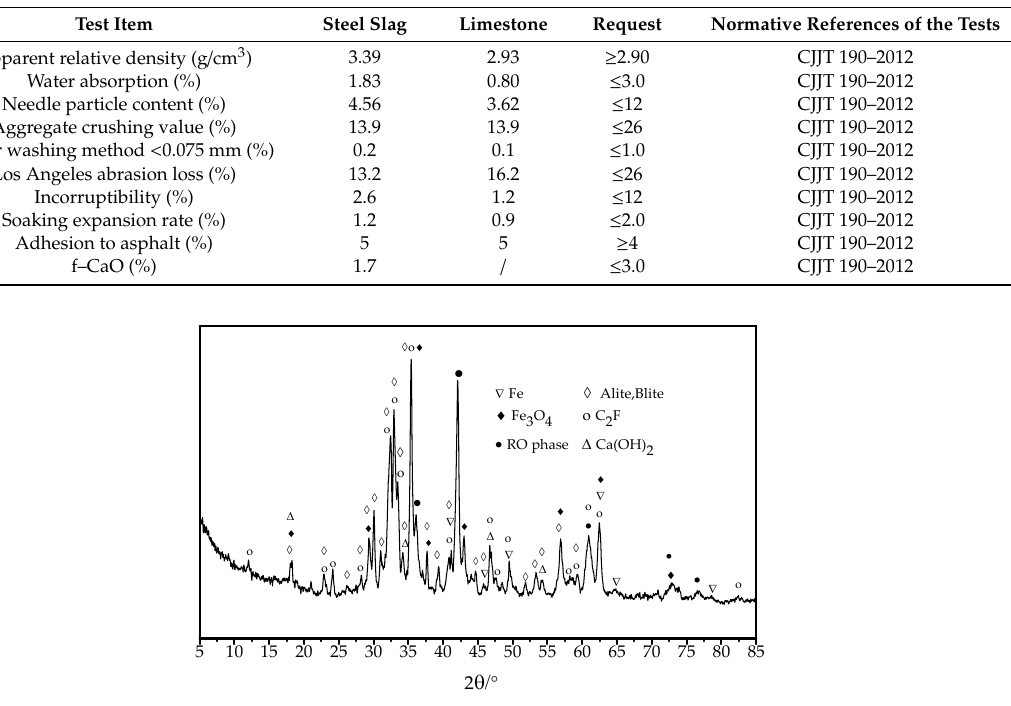
Figure 1. XRD test results for the steel slag aggregate.